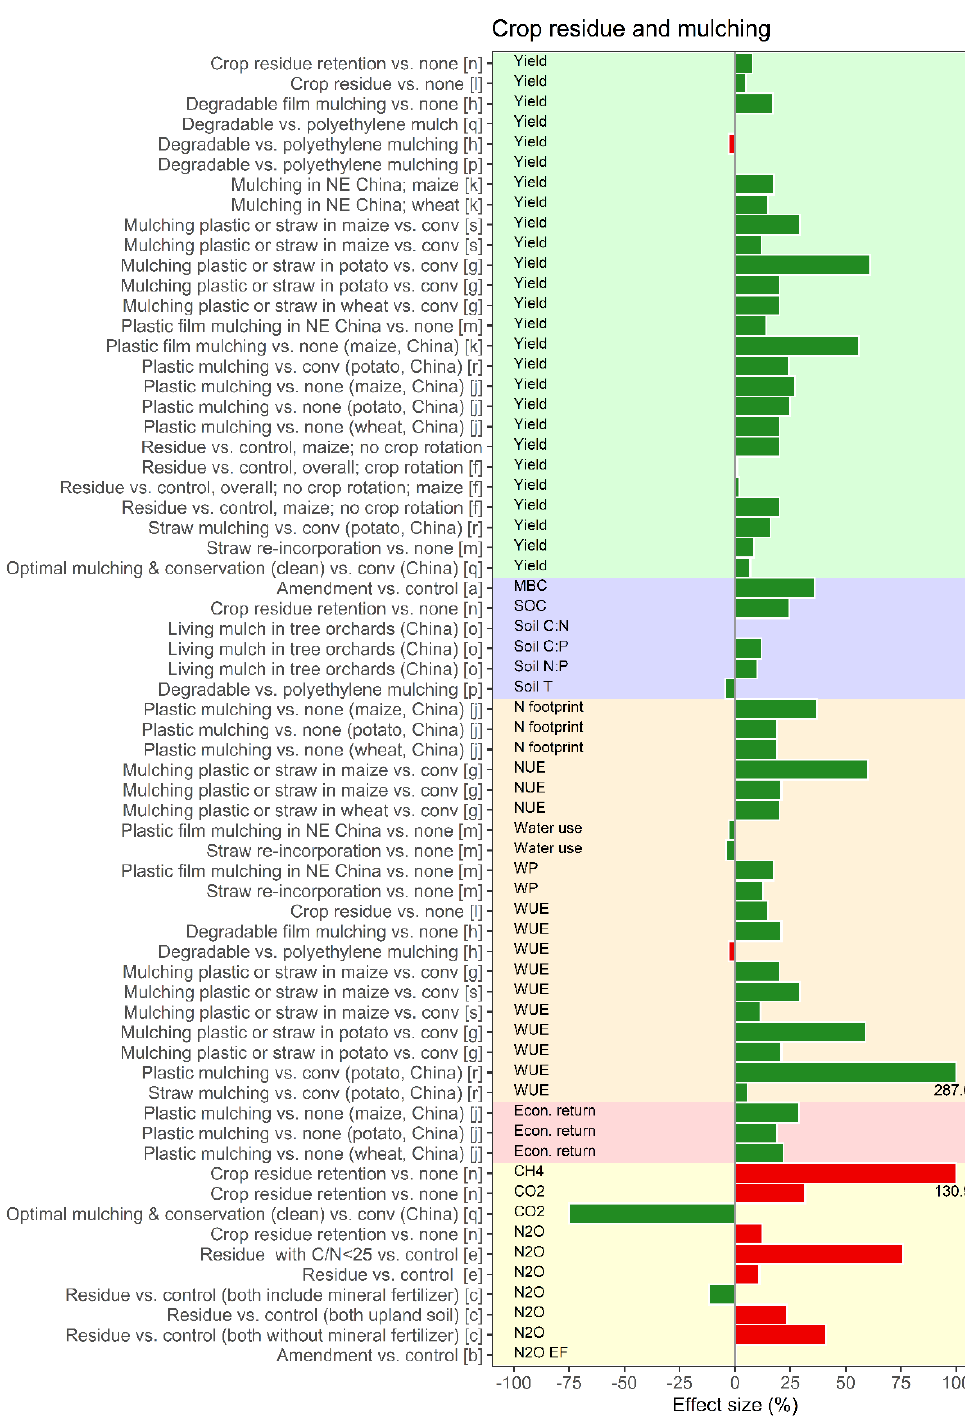
Figure 6. Overall response ratios reported in meta-analysis studies on crop residues and mulching grouped per area of interest (light green: agronomic; light blue: soil quality; light orange: resource use efficiency; light brown: economic; light yellow: environmental impacts). The management or treatment comparison is indicated outside the y-axis and the variable to which the data refer are listed inside the y-axis (abbreviations can be found in Table A1). Green bars indicate improvement, red bars indicate worsening. See also Table S8. [a]: [174] ; [b] [175] ; [c]: [176] ; [d]: [177] ; [e]: [178] ; [f]: [22] ; [g]: [179] ; [h]: [172] ; [i]: [180] ; [j]: [181] ; [k]: [182] ; [l]: [183] ; [m]: [97] ; [n]: [184] ; [o]: [185] ; [p]: [173] ; [q]: [186] ; [r]: [187] ; [s]: [188] .